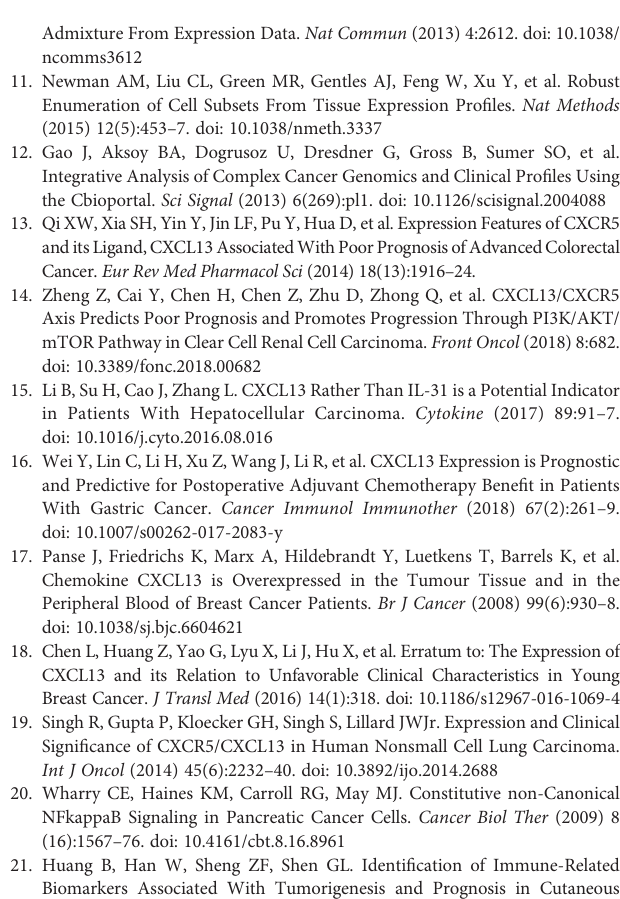
Supplementary Figure 1 | The correlation between CXCL13 expression and immune scores and stromal scores. Supplementary Figure 2 | The correlation between CXCL13 expression and 22 kinds of immune cell in fi ltration. The immune cell in fi ltration was calculated by CIBERSORT algorithm. Supplementary Figure 3 | (A) The correlation between CXCL13 expression and immune in fi ltration of CD8+ T cell and macrophage by the algorithms of MCPCOUNTER, QUANTISEQ, TIMER, and XCELL. (B) Theresults ofRDAanalysis. Supplementary Figure 4 | KEGG pathway analysis of CXCL13 by GSEA analysis based on the GTEx. Supplementary Figure 5 | GO functional annotation of CXCL13 by GSEA analysis based on the GTEx. Supplementary Figure 6 | KEGG pathway analysis of CXCL13 by GSEA analysis based on the TCGA. Supplementary Figure 7 | GO functional annotation of CXCL13 by GSEA analysis based on the